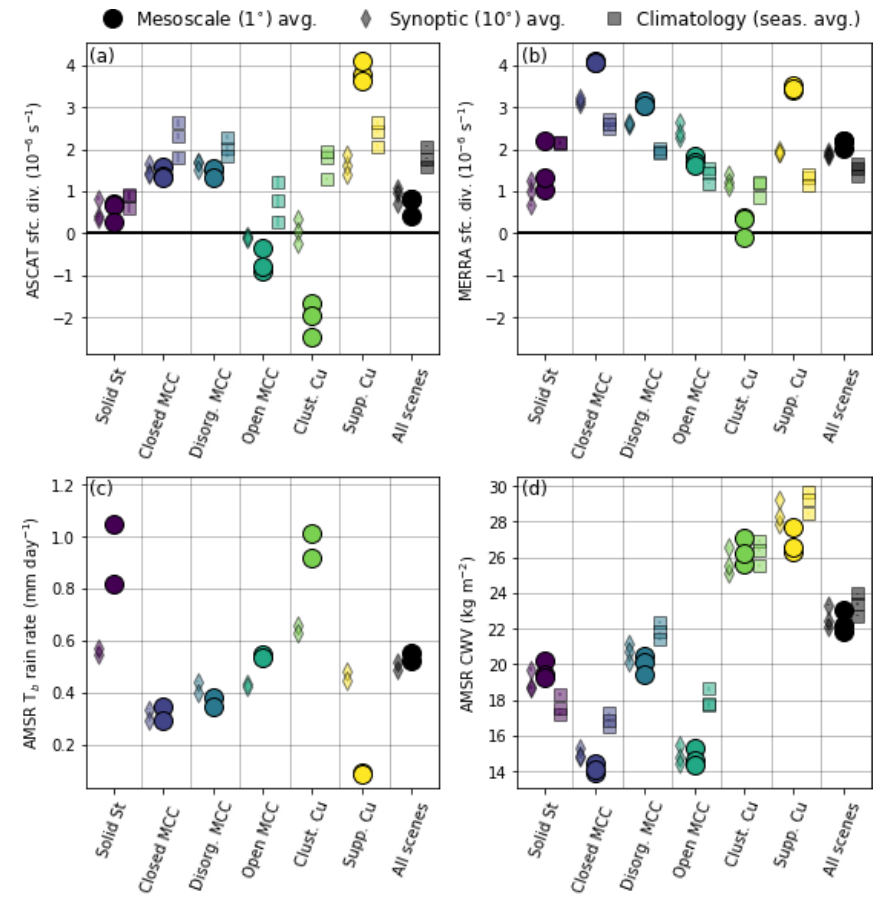
Figure 8. Same as Fig. 5 but with (a) ASCAT surface wind divergence, (b) MERRA-2 surface wind divergence, (c) AMSR-2 rain rate, and (d) AMSR-2 column water